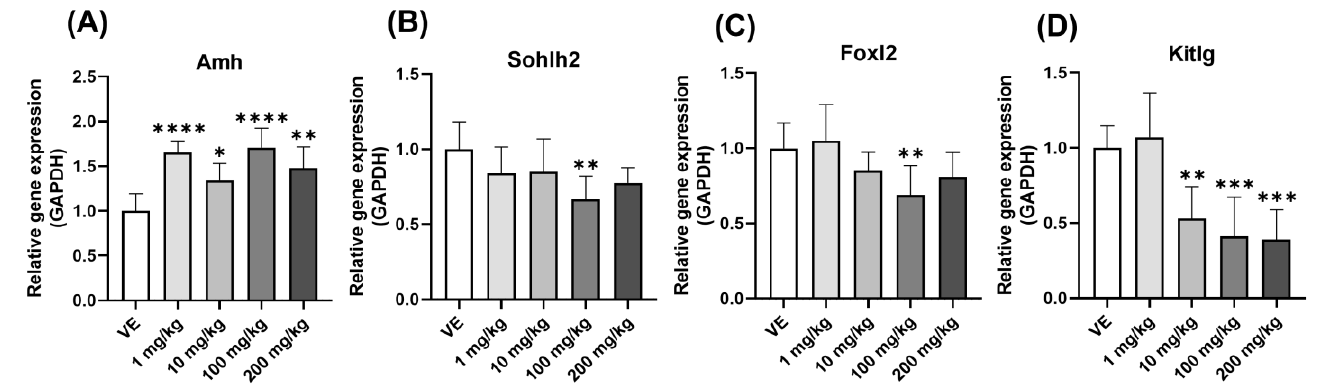
Figure 8. Changes in the expression level of genes involved in ovarian follicle formation when exposed to D5. Gene expression confirmed by qPCR in the ovary of rats exposed to D5 for four weeks: ( A ) Amh expression level; ( B ) Sohlh2 expression level; ( C ) Foxl2 expression level; ( D ) Kitlg expression level. The values are expressed as means ± SD. * p < 0.05, ** p < 0.01, *** p < 0.001 and **** p < 0.0001 vs. vehicle. VE—vehicle, N = 9~10.